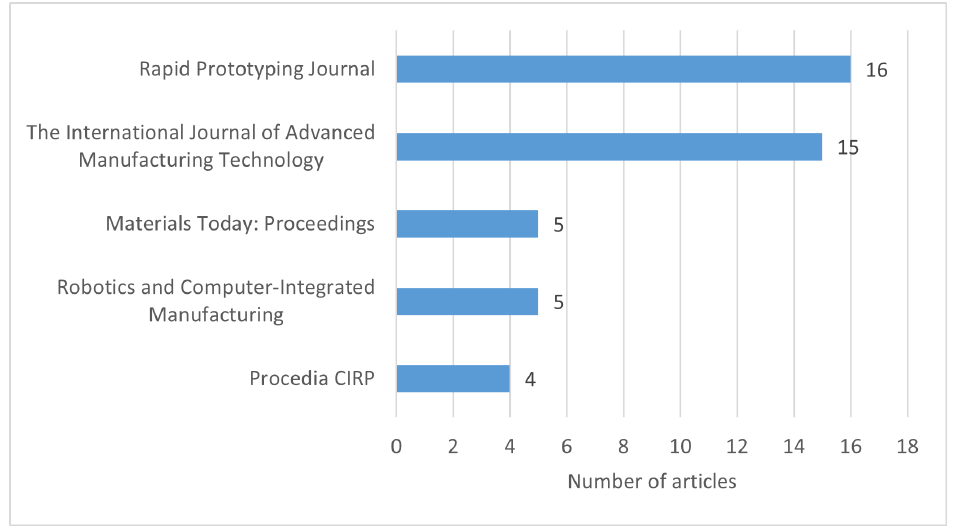
Figure 2. Top five journals that published the most articles about MADM methods in AM. From the perspective of the citations of the published articles, the ten articles about MADM methods in AM with the greatest number of total citations are, as listed in Figure 3 (data source: Google Scholar, accessed on 23 November 2022), Chakraborty [62], Byun and Lee [78] , Byun and Lee [13], Vahdani et al. [44], Ic [45], Roberson et al. [58], Rao and Padm [61], Rao and Patel [80], Pham et al. [11], and Byun and Lee [12]. If the evaluation criterion is the average number of citations per year, the top ten articles about MADM methods in AM are, as listed in Figure 4 (data source: Google Scholar, accessed on 23